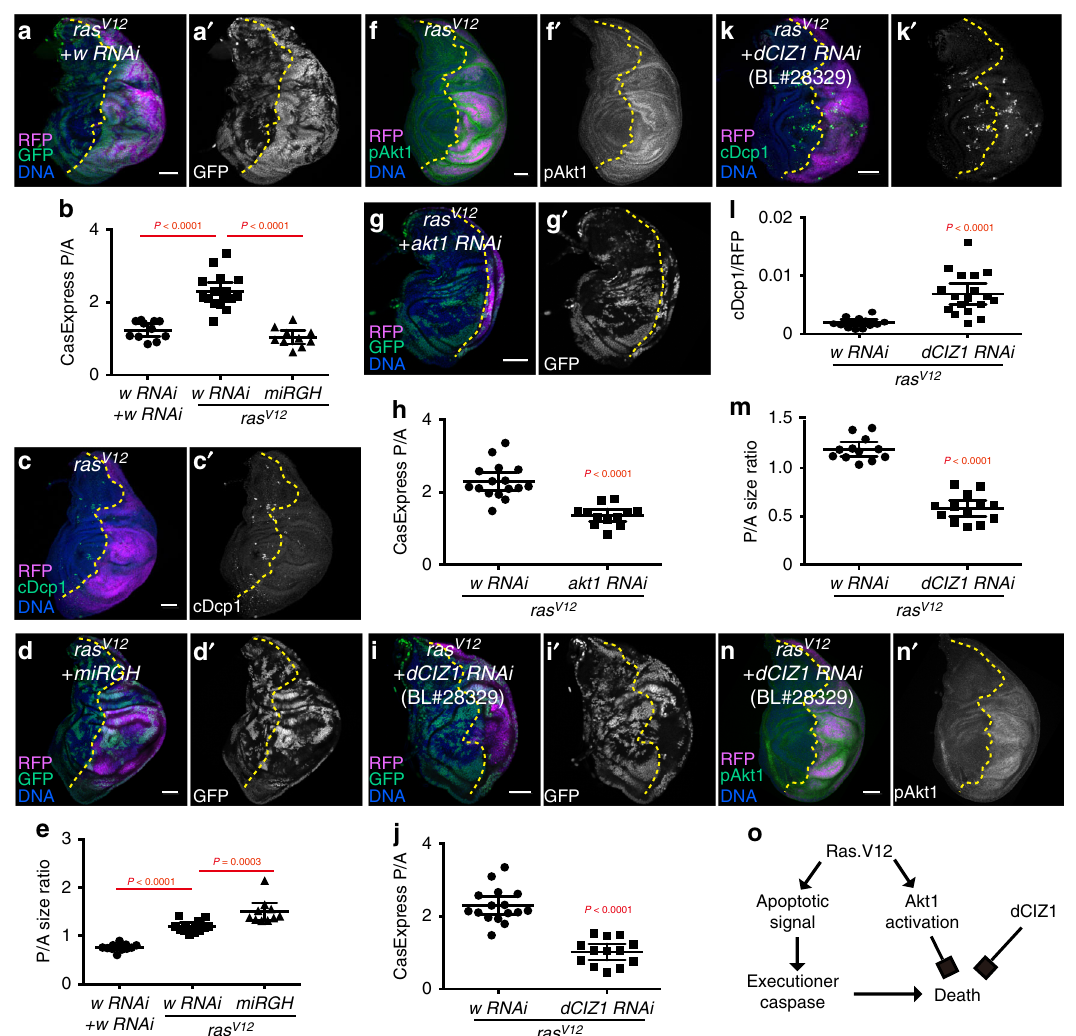
Fig. 8 Akt1 and dCIZ1 promote survival from apoptotic executioner caspase activation in tissues with oncogenic Ras V12 . ( a ) Expression of ras V12 induced CasExpress activation (GFP). ( b ) Quanti fi cation of CasExpress activation in discs expressing w RNAi + w RNAi ( n = 11), ras V12 + w RNAi ( n = 16), ras V12 + miRGH ( n = 10) under en-Gal4 . ( c ) Expression of ras V12 induced little cell death. ( d ) miRGH inhibited CasExpress activation in ras V12 -expressing compartment. ( e ) Expression of ras V12 induced overgrowth of the compartment, which was further increased by overexpression of miRGH . n = 11 ( w RNAi + w RNAi ), 12 ( ras V12 + w RNAi ), 10 ( ras V12 + miRGH ). ( f ) Expression of ras V12 activated Akt1. ( g , h ) Knocking down akt1 suppressed ras V12 -induced CasExpress activation. n = 16 ( ras V12 + w RNAi ), 12 ( ras V12 + akt1 RNAi ). ( i , j ) Knocking down dCIZ1 blocked CasExpress activation in ras V12 -expressing compartment. n = 16 ( ras V12 + w RNAi ), 13 ( ras V12 + dCIZ1 RNAi ). ( k , l ) Knocking down dCIZ1 induced cell death (cDcp1 + ) in ras V12 -expressing compartment. n = 13 ( ras V12 + w RNAi ), 18 ( ras V12 + dCIZ1 RNAi BL#28329). ( m ) Knocking down dCIZ1 suppressed ras V12 -induced overgrowth. n = 12 ( ras V12 + w RNAi ), 13 ( ras V12 + dCIZ1 RNAi BL#28329). ( n ) Expression of dCIZ1 RNAi (BL#28329) did not affect ras V12 -induced Akt1 activation. ( o ) The schematic of the role of Akt1 and dCIZ1 in tissues with oncogenic Ras V12 . Gal80 ts was used in the experiments in this fi gure to control the timing of ras V12 expression. In all images, RFP marks UAS transgene expressing region. The yellow dotted lines mark the boundary between the anterior compartment and the posterior compartment. Scale bar is 50 μ m. In all plots, n is the number of biological independent samples used for quanti fi cation. The data are presented as mean values ± 95% con fi dence interval. Statistical signi fi cance was determined after logarithm transformation using unpaired two-tailed t -test ( h , j , l , m ) or one-way ANOVA ( b , e ). The Tukey test was used to derive adjusted P -value for multiple comparisons. Source data are provided as a Source Data fi